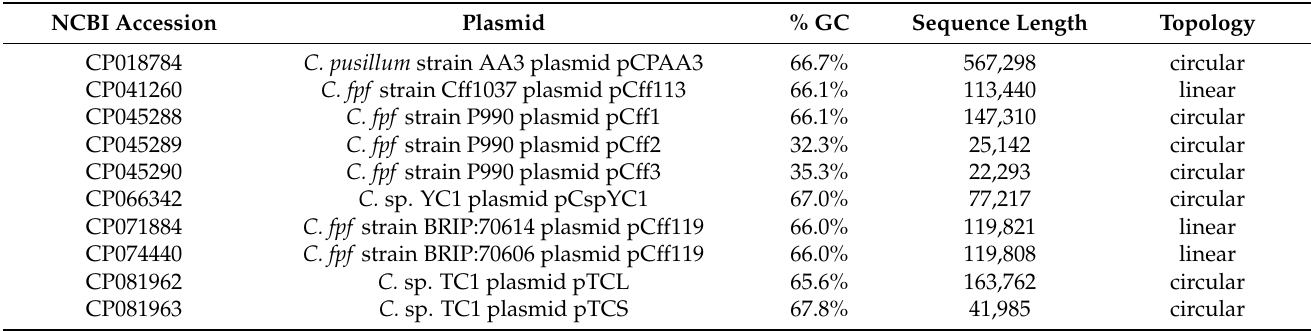
Table 3. Curtobacterium plasmid genomes deposited in the NCBI Genome database as of October